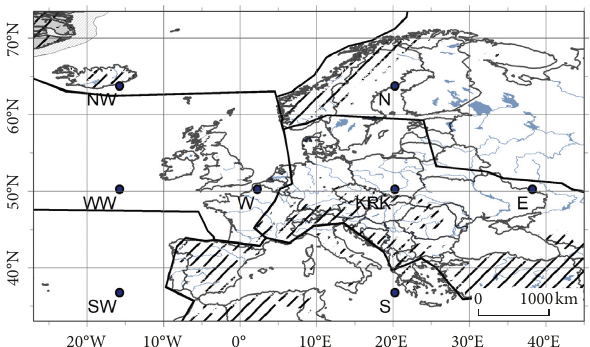
Figure 1: Study area with selected grid point locations representing different humidity regions in Europe (polygons); slanted lines are used to denote areas situated above the average 950hPa